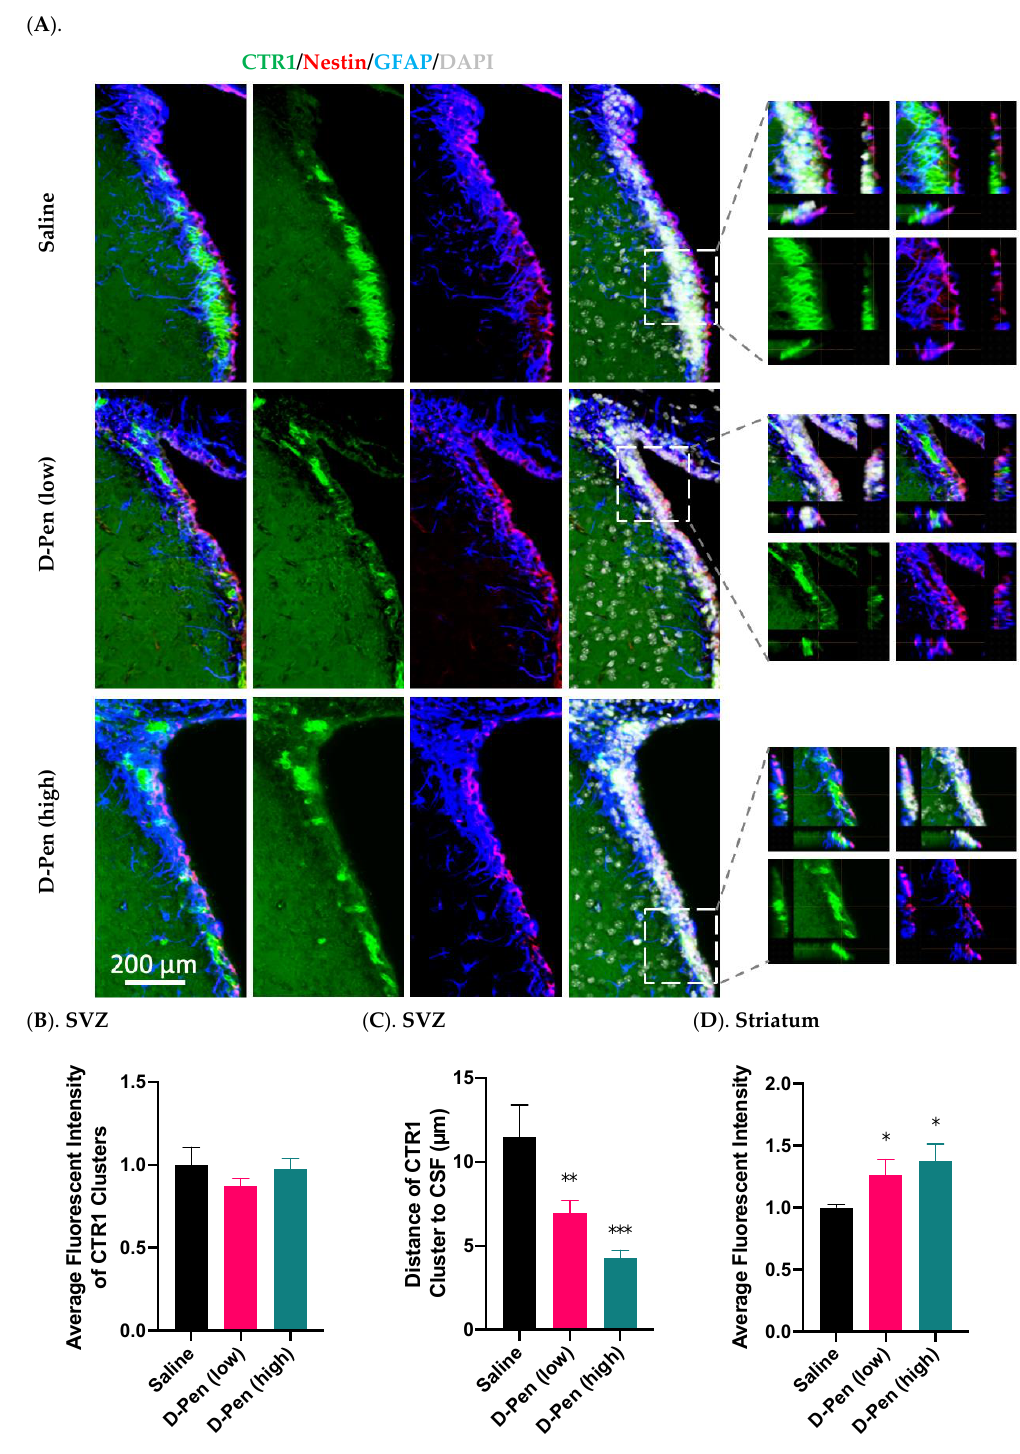
Figure 10. Expression of CTR1 in SVZ and striatum following long-term ICV D-Pen infusion. ( A ) CTR1 expression in the SVZ and colocalization with adult NSPCs. CTR1 clusters were further 3D- magnified for improved observations. Scale bar = 200 µm. ( B ) Quantification of average immunofluorescent intensities of CTR1 clusters in SVZ using multiple slices per brain. ( C ) Quantification of the average distance of CTR1 clusters in SVZ to the CSF using multiple slices per brain. ( D ) Quantification of average CTR1 immunofluorescent intensity in striatum using multiple slices per brain. For panels ( B – D ), data represent mean ± SD, n = 3/group. * p < 0.05, ** p < 0.01, *** p < 0.001, as compared with the